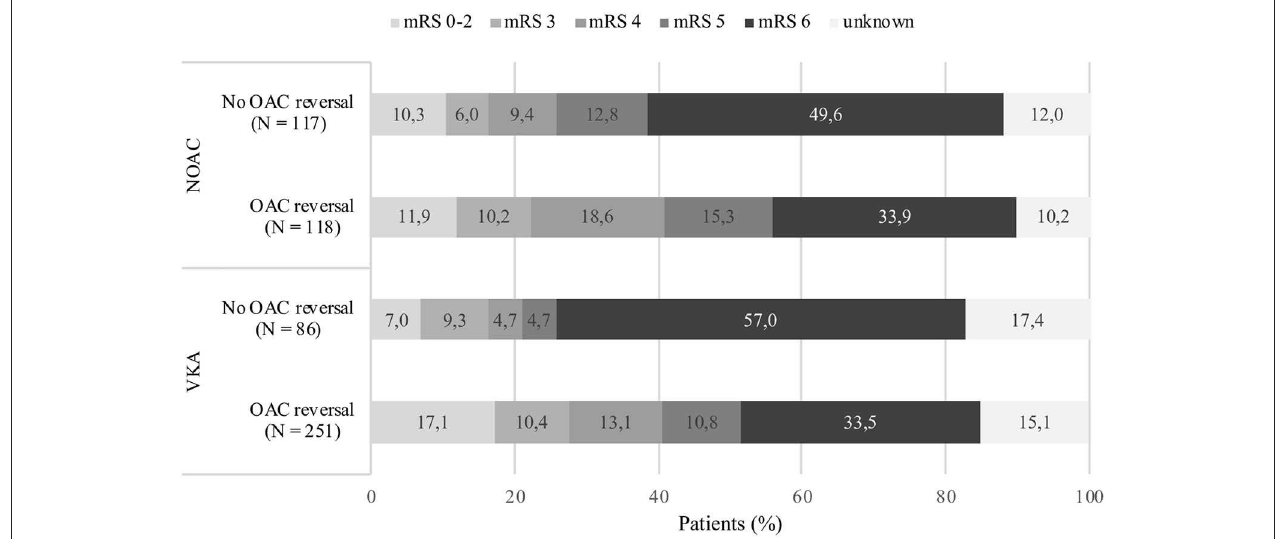
FIGURE 4 | Crude data comparing 90-day functional outcome following oral anticoagulant related intracerebral hemorrhage. Figure includes patients lost to follow-up. ICH, intracerebral hemorrhage; VKA, vitamin K antagonist; NOAC, non-vitamin K antagonist oral anticoagulant.